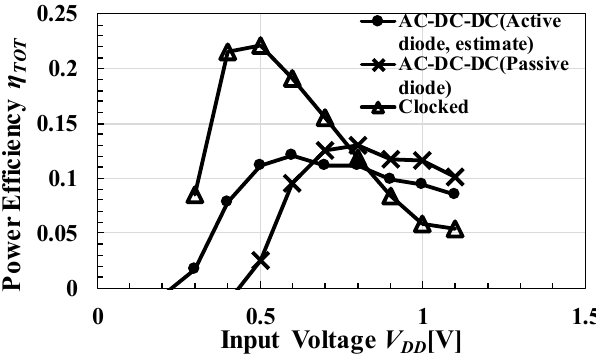
Figure 29. Simulated η TOT as a function of V DD ( f IN = 1 kHz, f CLK = 1 MHz, V DD = 0.5 V, R EH = 500 Ω ).